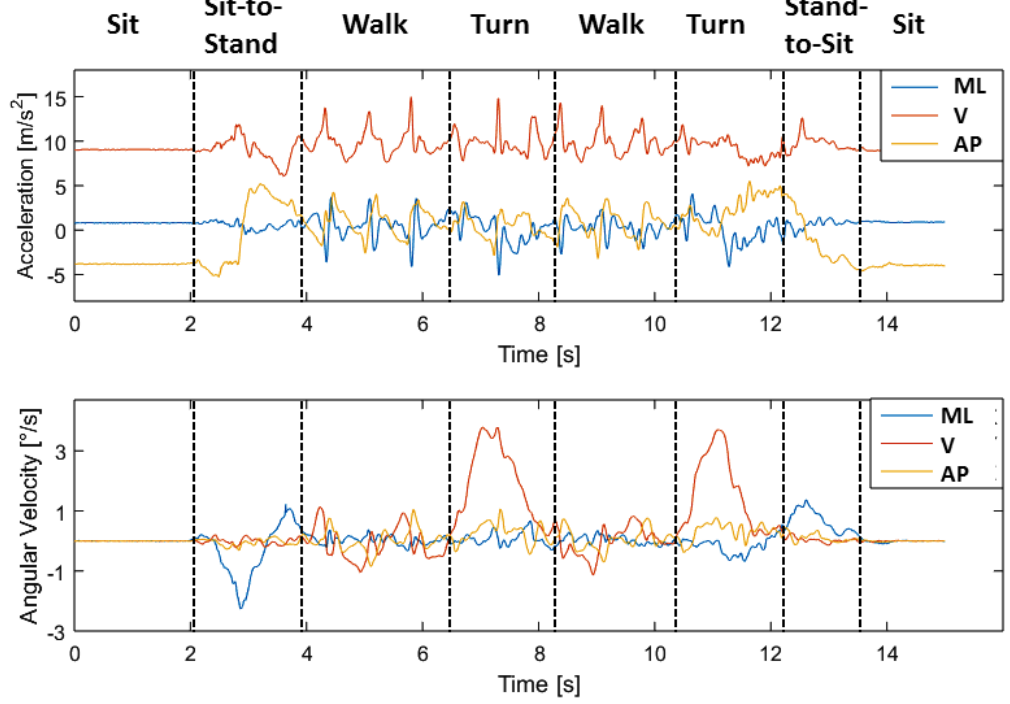
Figure 5. Example of the acceleration and gyroscope data during a TUG test. The TUG test consists of several components of everyday movements, which are marked in the graph. Each component is characterized by specific features, which are derived for machine learning classification. Medio-Lateral (ML); Vertical (V); Anterior-Posterior